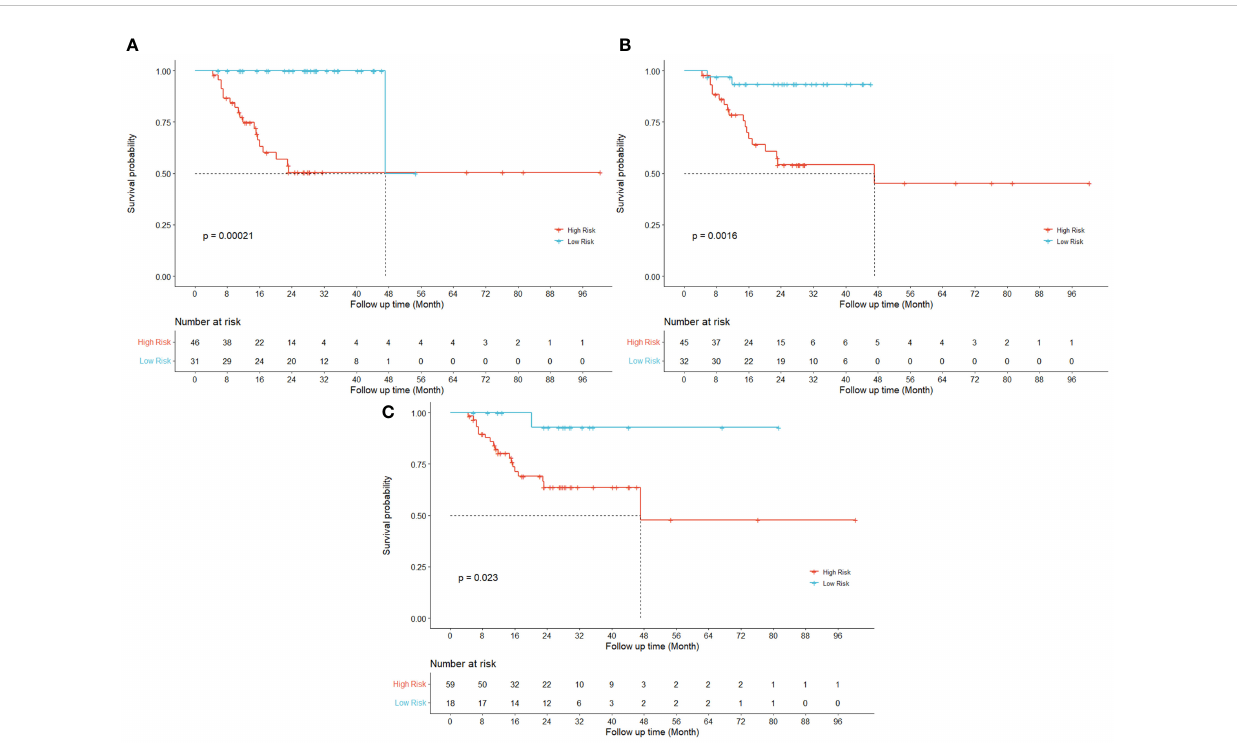
FIGURE 2 Kaplan-Meier curves for LRRFS. Univariate results are shown for three different principal components in radiomic ( (A) RPC0) and dosiomic ( (B) DPC0; (C) DPC3) features